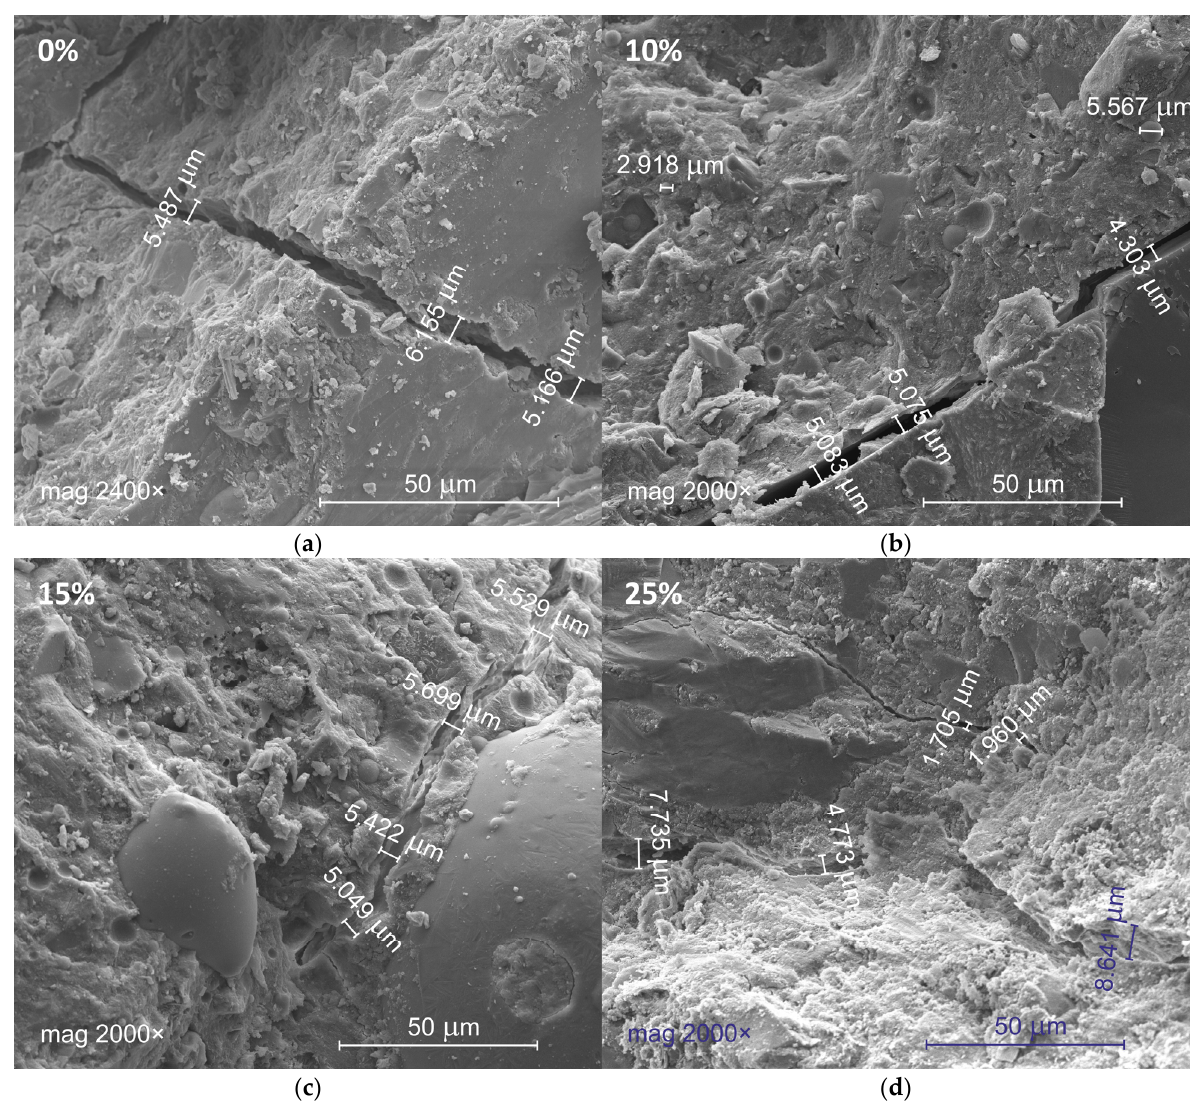
Figure 14. Differences in microcracks widths of HPC with CSF content of ( a ) 0%; ( b ) 10%; ( c ) 15%; ( d ) 25%.